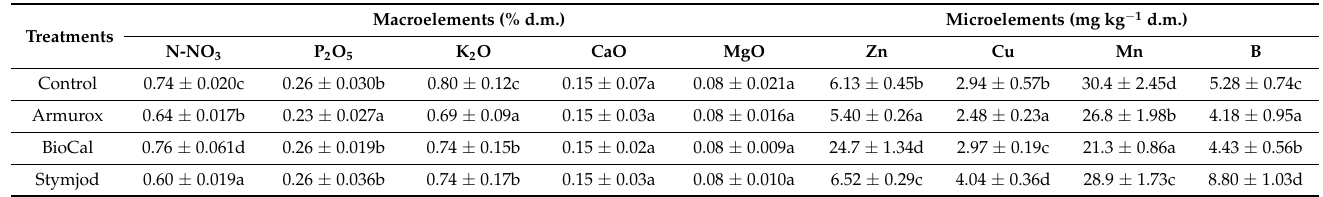
Table 4. The content of macro- and microelements of highbush blueberry fruits in 2021.